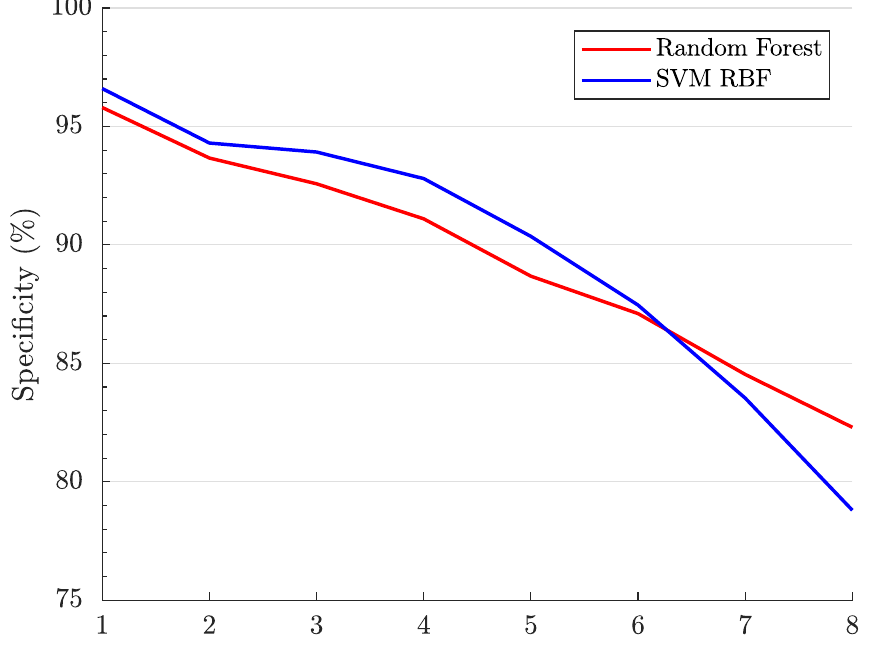
Figure 2. Specificity Across Different Clinical miRNA